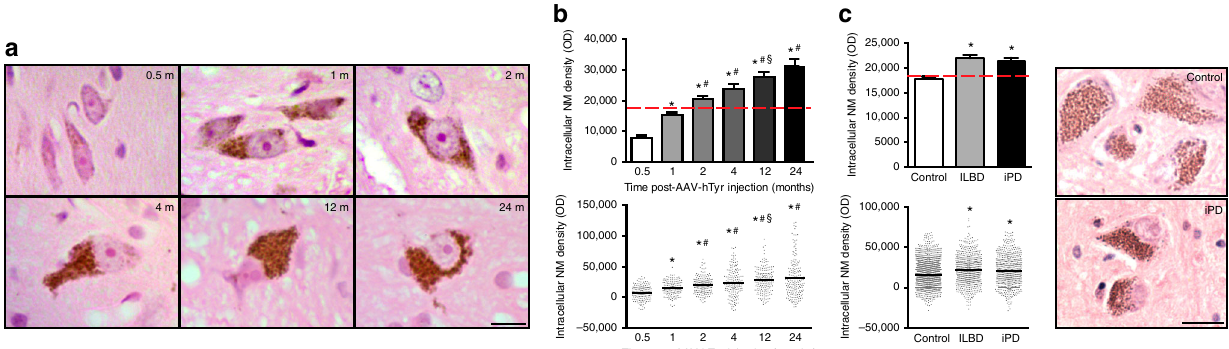
Fig. 2 Age-dependent NM accumulation in AAV-hTyr-injected rats. a Hematoxylin-eosin (H&E)-stained brain sections showing progressive intracellular NM accumulation (brown) within ipsilateral SNpc DA neurons from AAV-hTyr-injected rats. Scale bar, 12.5 μ m. b Quanti fi cation of intracellular NM optical density in ipsilateral SNpc DA neurons of AAV-hTyr-injected rats. * p < 0.05, compared to 0.5 m; # p < 0.05, compared to 1 m; § p < 0.05, compared to 2&4 m. c Left, quanti fi cation of intracellular NM optical density in post-mortem SNpc sections from elderly human (average 80 years old) control subjects, age- matched ILBD subjects and age-matched idiopathic PD patients. * p < 0.05, compared to control subjects. Right, H&E-stained human brain sections. Scale bar, 12.5 μ m. In b , c values are mean ± SEM. In b , n = 163 neurons from n = 7 rats (0.5 m), n = 136 neurons from n = 5 rats (1 m), n = 174 neurons from n = 5 rats (2 m), n = 162 neurons from n = 7 rats (4 m), n = 172 neurons from n = 6 rats (12 m), n = 179 neurons from n = 6 rats (24 m). In c , n = 1436 neurons from n = 6 control subjects, n = 640 neurons from n = 3 ILBD subjects, n = 644 neurons from n = 10 PD subjects. See Supplementary Table 1 for additional information on the human subjects used for the analyses in c . Statistical analyses: ANOVA on ranks; Dunn ’ s post-hoc test. Photomicrographs correspond to 5- μ m-thick